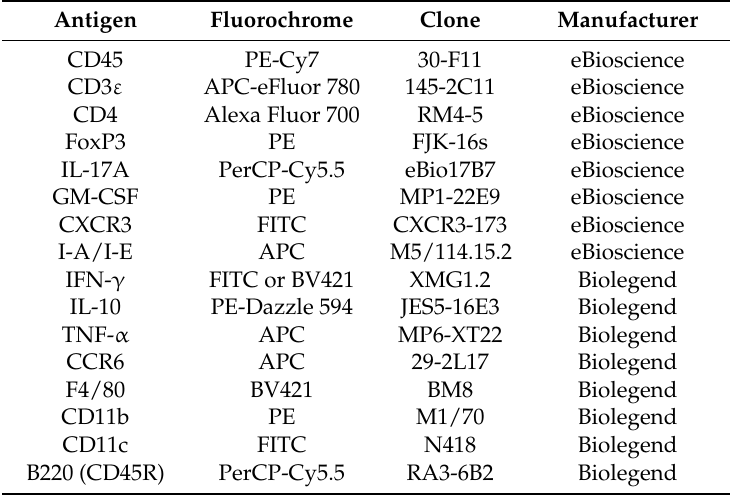
Table 2. Antibodies used in the experiments of surface and intracellular FACS